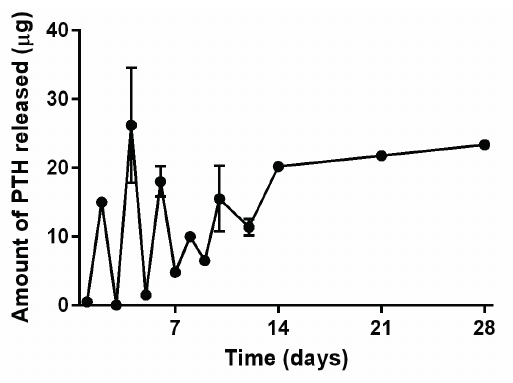
Figure 10. Release profile of PTH from NPTH engrafted